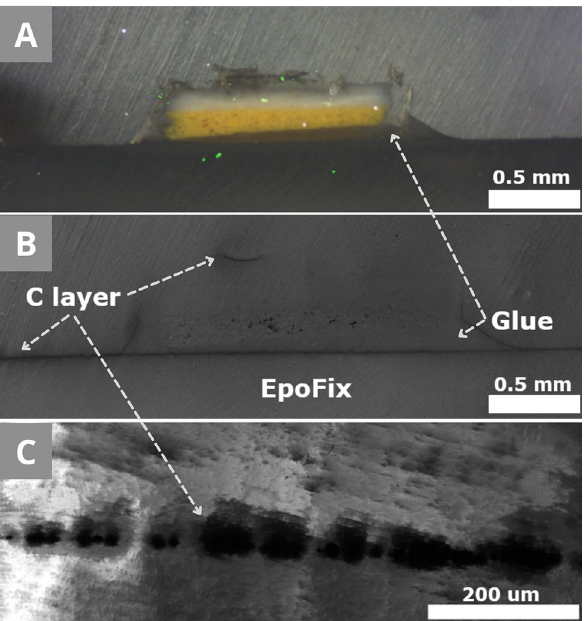
Figure 10. Preparation B of MS2. (A) Bright light microscope image. The sample is not in contact with the first C-layer. The green speckles are due to the camera. (B + C) SEM-SE + BSE imaging 2 kV | 10 Pa. (B) The carbon line is broken around the sample and it is not regular. (C) The detail of the uneven carbon layer of